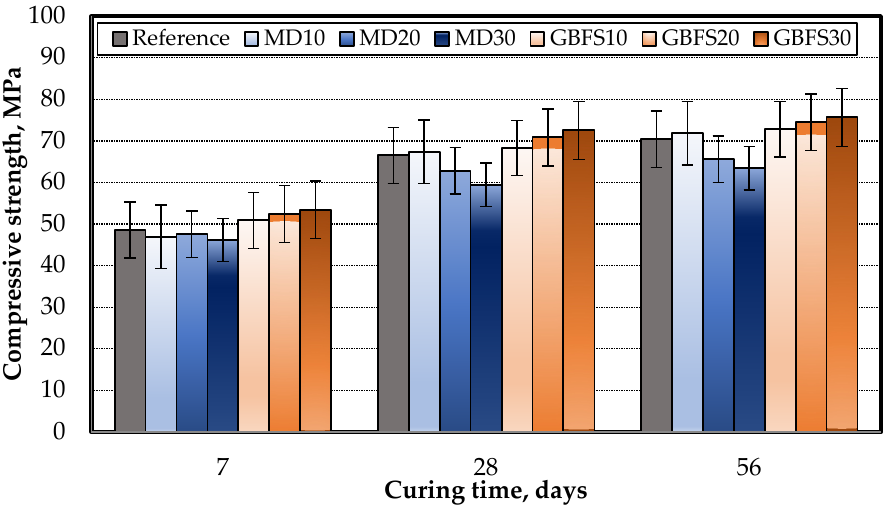
Figure 6. Compressive strength of the SCC specimens.